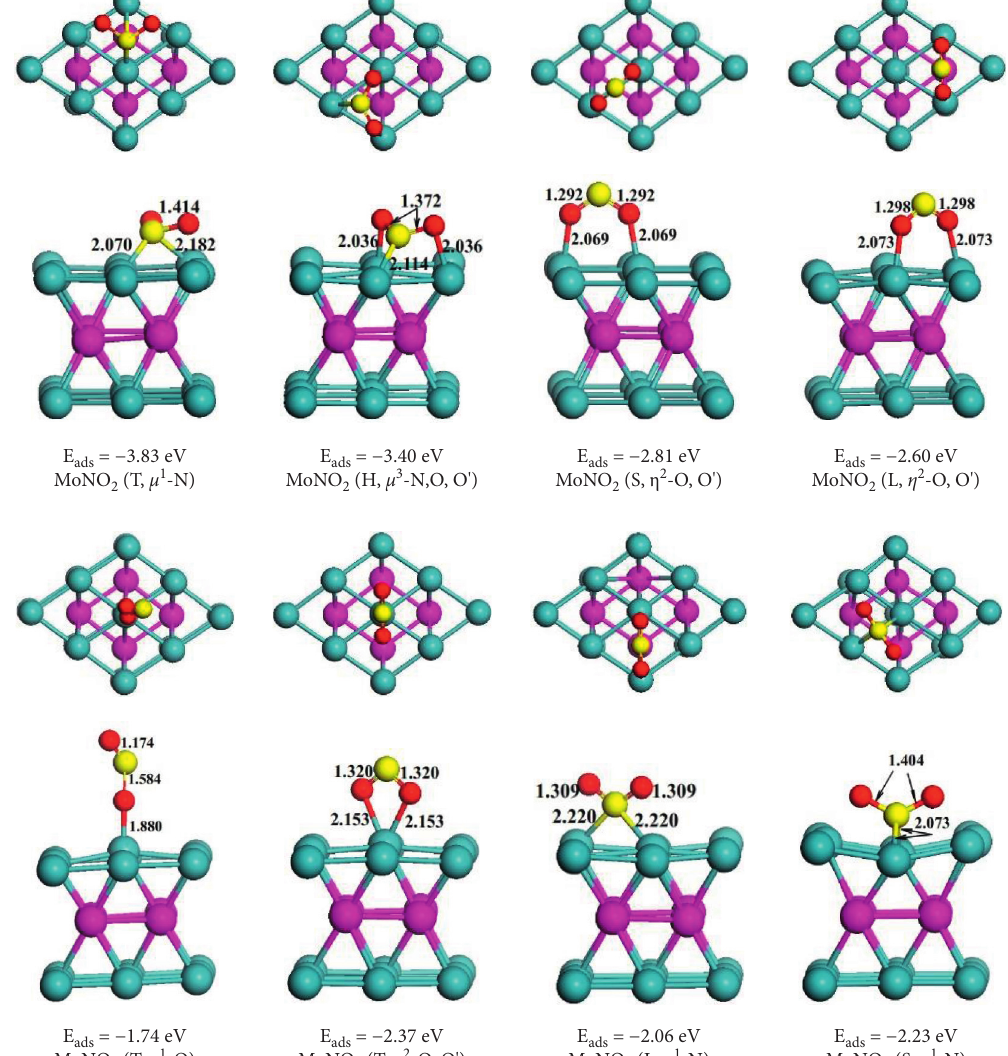
Figure 6: Adsorption structure of NO